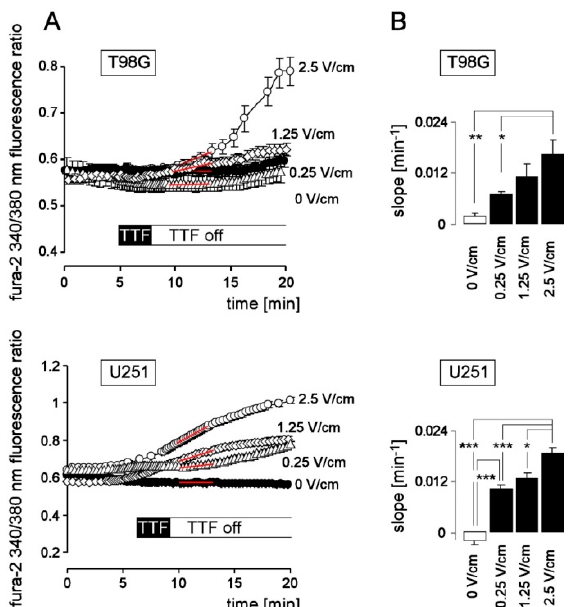
Figure 2. TTFields induce Ca 2+ signals in U251 and T98G human glioblastoma cells in a dose-dependent manner. ( A ) Time course of mean ( ± SE; n = 8–17) fura-2 340/380 nm fluorescence ratio as a measure of free [Ca 2+ ] i recorded in T98G (top) and U251 cells (bottom) during superfusion with 1 mM Ca 2+ -containing NaCl-solution before, during and after application of 0 (control), 0.25, 1.25, or 2.5 V/cm TTFields (200 kHz) field strength for 3 min. ( B ) Mean ( ± SE; n = 8–55) slope (as indicated by red lines in ( A ) of the TTFields-induced increase in fura-2 340/380 nm fluorescence ratio as calculated for U251 (left), and T98G (right) cells. *, ** and *** in ( B ) indicate 6 p ≤ 0.05, 6 p ≤ 0.01, and 6 p ≤ 0.001, respectively, (Welch)-corrected t-test and Bonferroni correction for 6 pairwise comparisons.